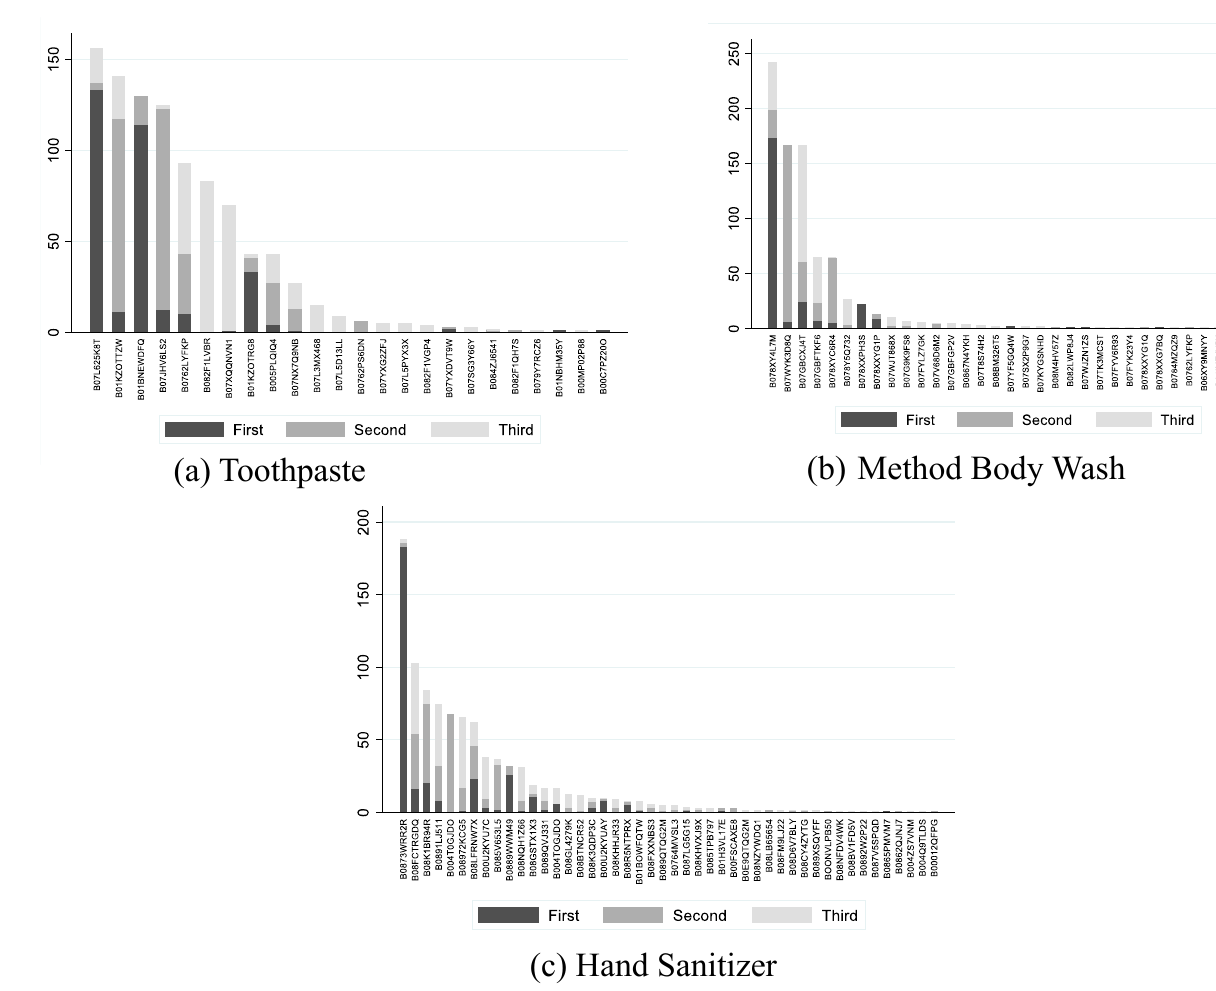
Figure 3. Example gross and net prices for a 6-pack of Colgate Cavity Protection Toothpaste with Fluoride (ASIN B01BNEWDFQ). Keepa (https://keepa.com/) was used to track gross prices. Keepa indicates that gross prices may vary across time but not across participants, which was confirmed by our data. To check for correlation between coupon offering and gross price, we compared, for all ASINs offering coupons, the average gross price across the participants who received a coupon and those that did not. The results, included in Table 4, show that, of the 16 ASINs in our data where coupons were offered, 4 had an increase in the gross price for listings with coupons, 4 had a decrease in price, and 8 did not change, suggesting that Amazon does not increase the gross price when they offer coupons to customers.